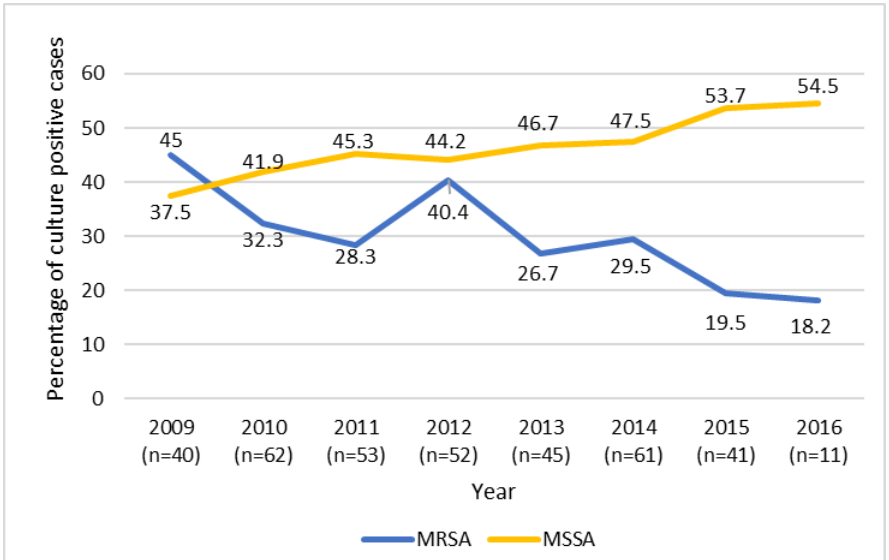
Figure 1. Percentage of Methicillin-resistant Staphylococcus aureus and Methicillin-susceptible Staphylococcus aureus septic arthritis and osteomyelitis cases out of total culture positive cases by year. Cochran–Armitage trend test for Methicillin-resistant Staphylococcus aureus (MRSA), Z-statistic = - 2.2876, one-sided p = 0.0111. Cochran–Armitage trend test for Methicillin-sensitive Staphylococcus aureus (MSSA), Z-statistic = +1.6523, and one-sided p = 0.0492. n = number of culture positive cases.